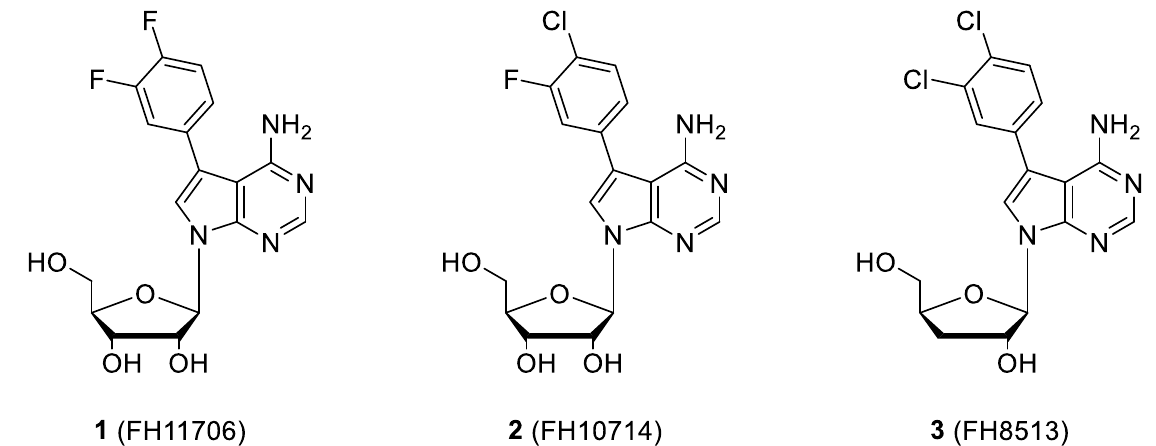
Figure 1. Structural formulae of the compounds under study. Internal codes between brackets.